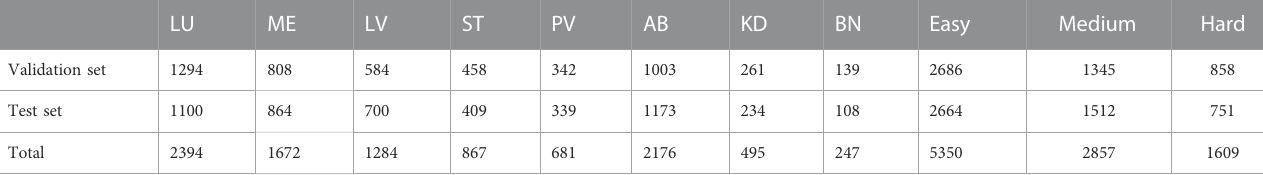
TABLE 1 Dataset information.